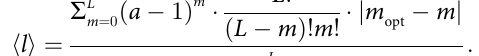
PLOS Computational Biology | https://doi.org/10.1371/journal.pcbi.1010524 September 19,